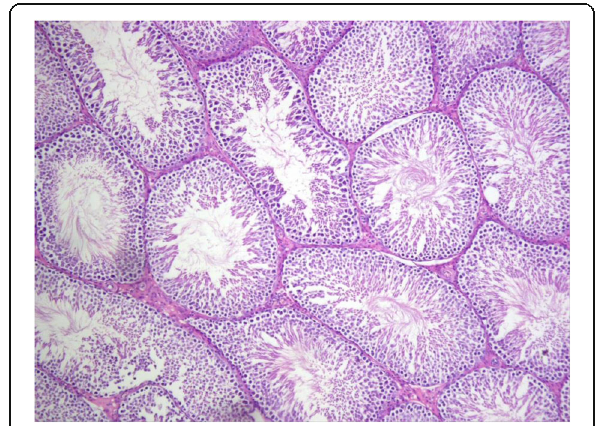
Fig. 1 Testicular section from the control group showing normal seminiferous tubules with normal spermatogenesis (H & E, × 100)